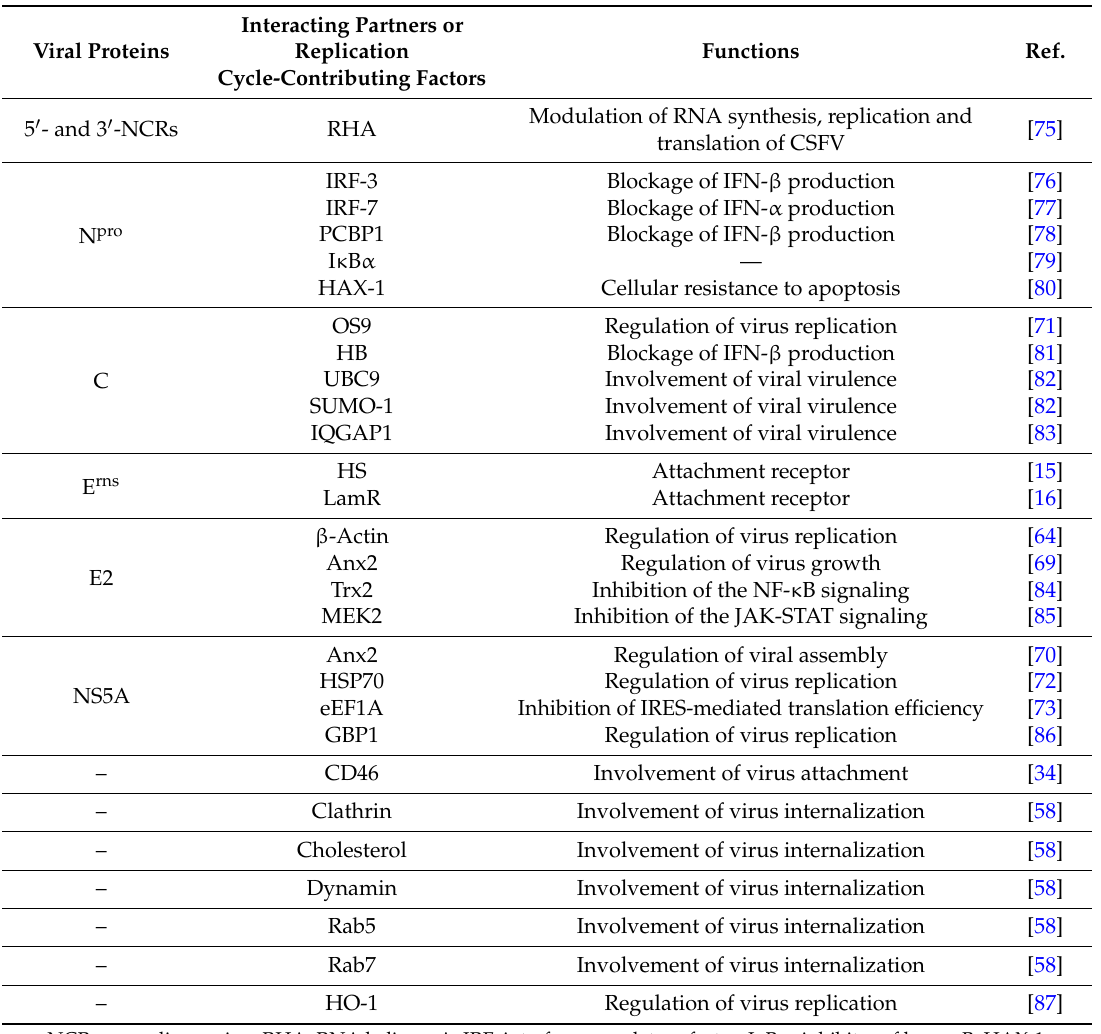
Table 1. Interactions between classical swine fever virus (CSFV) and host cellular proteins and replication cycle-contributing